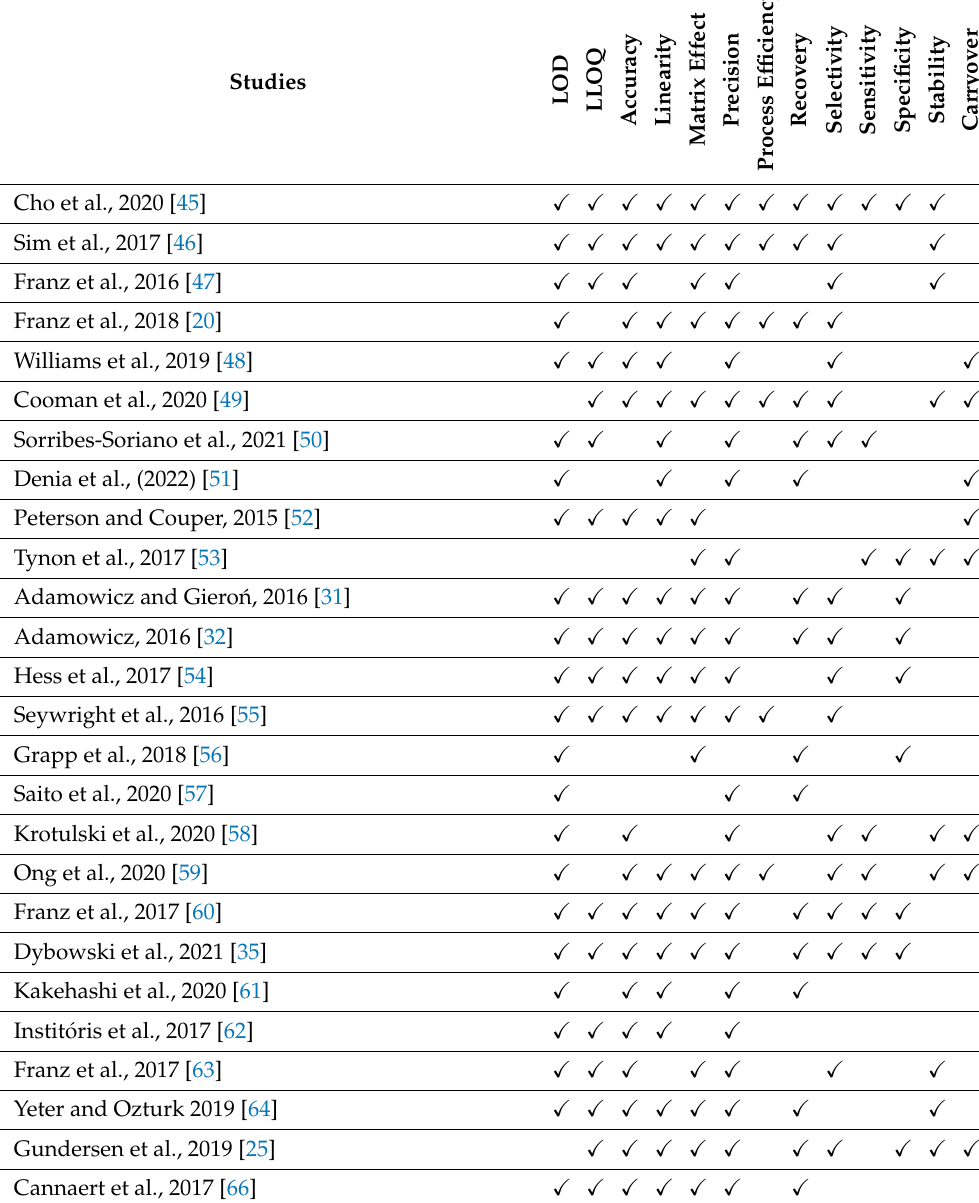
Table 3. Validation parameters measured in the analytical methods used for the identification of synthetic